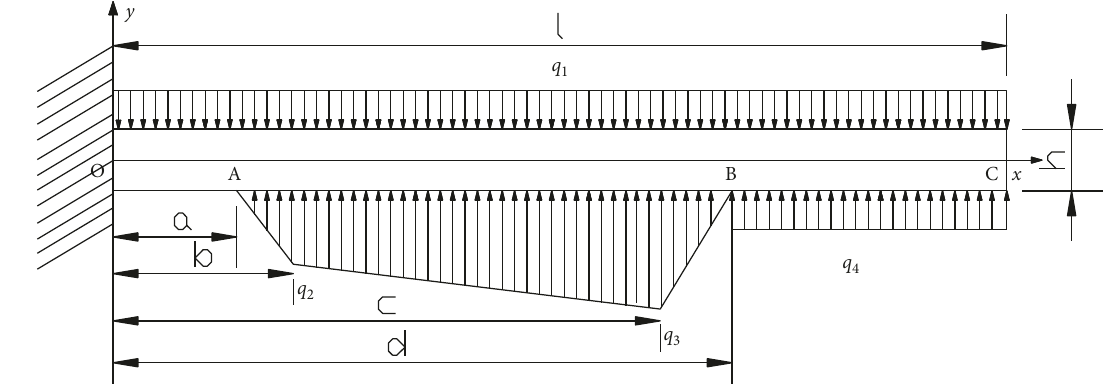
Figure 4: Simplified mechanical model for retracement